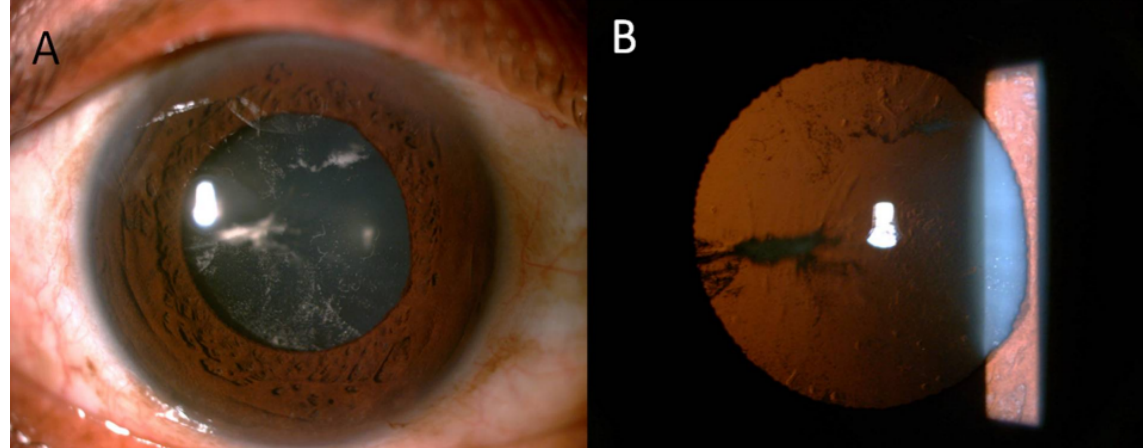
Figure 1: A: Multiple linear intralenticular opacities consistent with intralenticular steroid along with needle tract at 9 o’clock position. B: The needle tract seen more clearly on